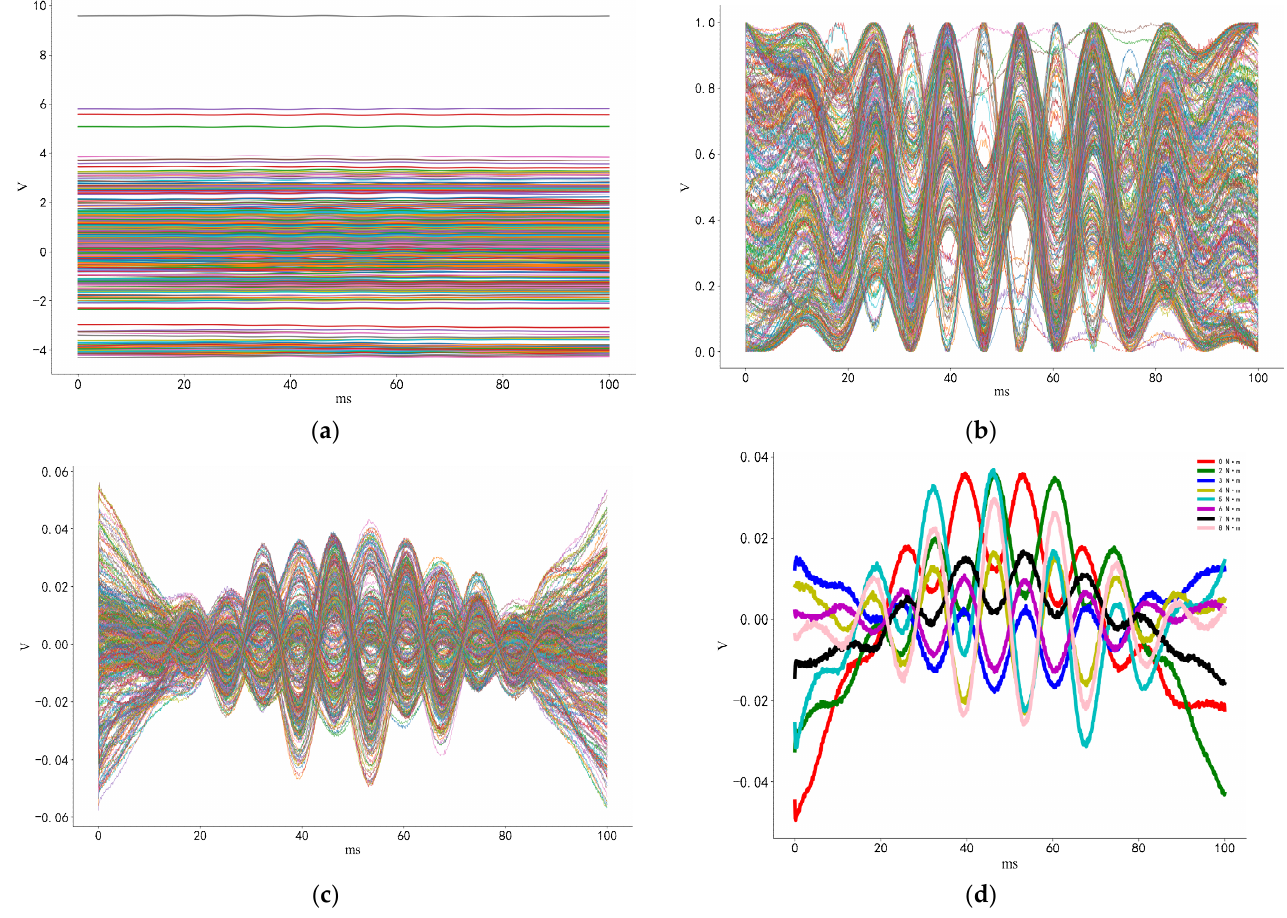
Figure 7. Results of different processing methods on time-reversal signals: ( a ) directly collected signals, ( b ) normalized signals, ( c ) filtered signals, and ( d ) filtered signals obtained from randomly selected experimental signals under each pre- load.